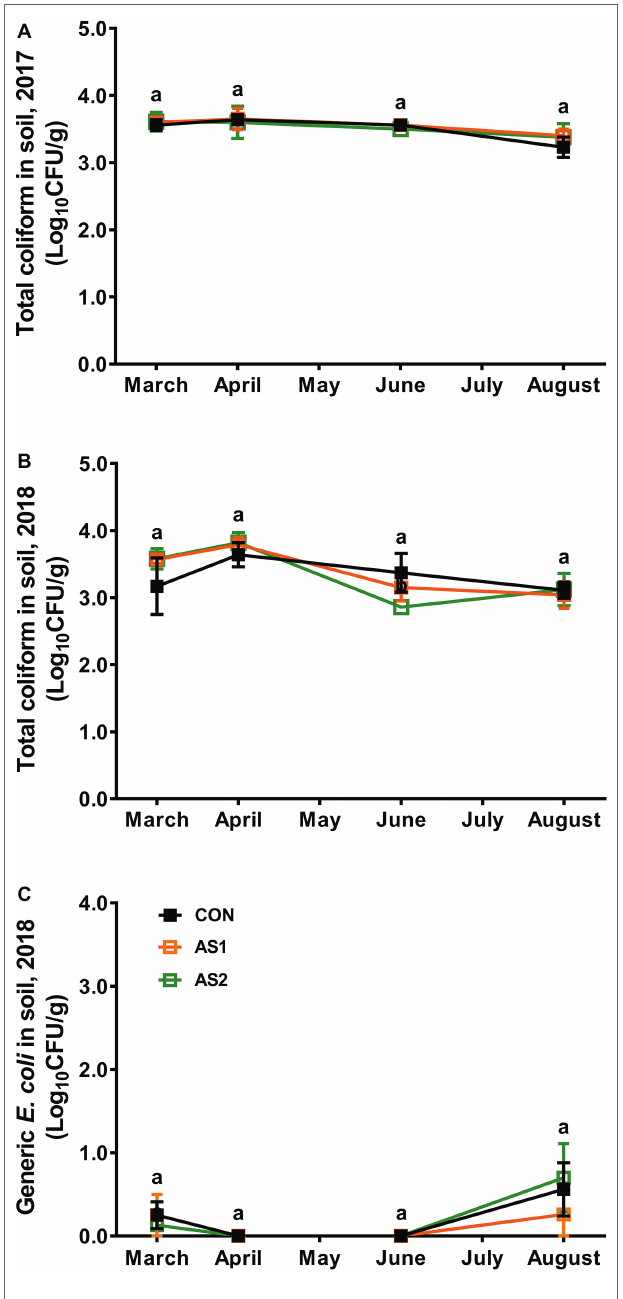
FIGURE 3 | Abundance of total coliforms in soil samples collected from the blueberry field during 2017–2018 production seasons. (A) Total coliform 2017; (B) Total coliform 2018; (C) Generic E. coli 2018. n = 4. Means at each sampling point without common letter differ significantly ( p < 0.05). CON, standard fertilization; AS1, manure-derived ammonium sulfate; AS2, manure-derived ammonium sulfate applied in split